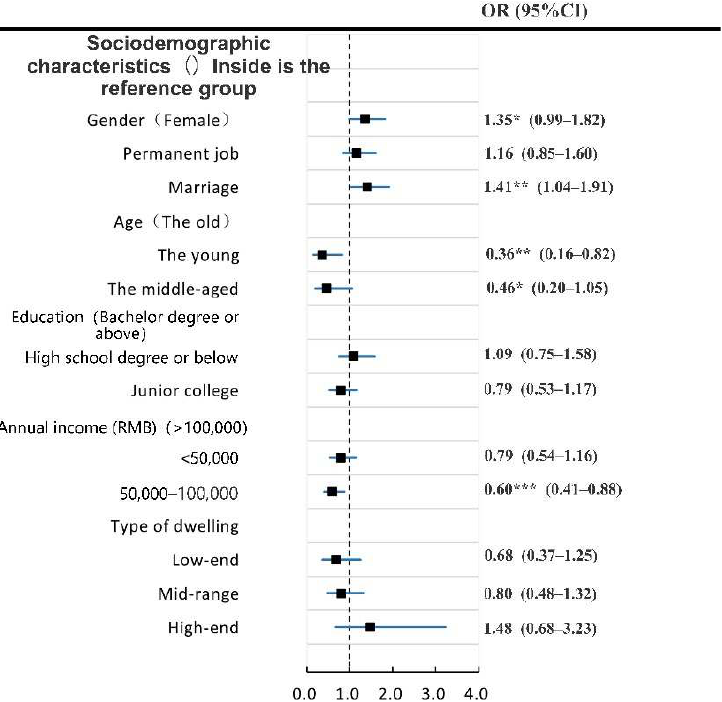
Figure 4. Univariate analysis of demographic variables, urban environmental evaluation and health facilities related variables and SRMH. Note: ***, ** and * respectively represent p < 0.01, p < 0.05, and p < 0.10. Variables ( n = 591).